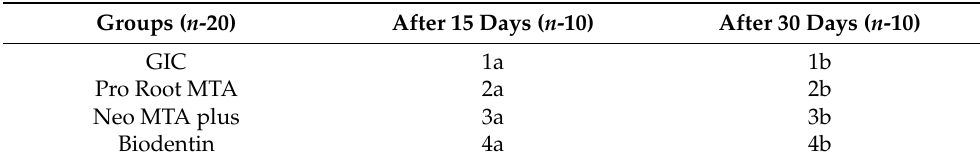
Table 1. Grouping of samples ( n —total number of